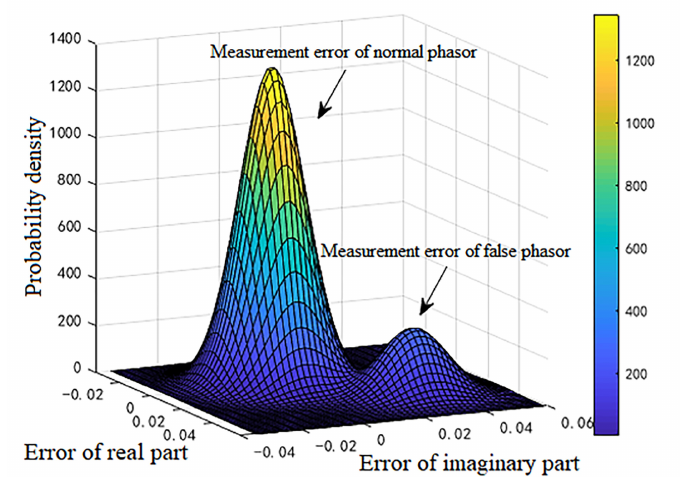
Figure 4. PDF of the GMM of measurement